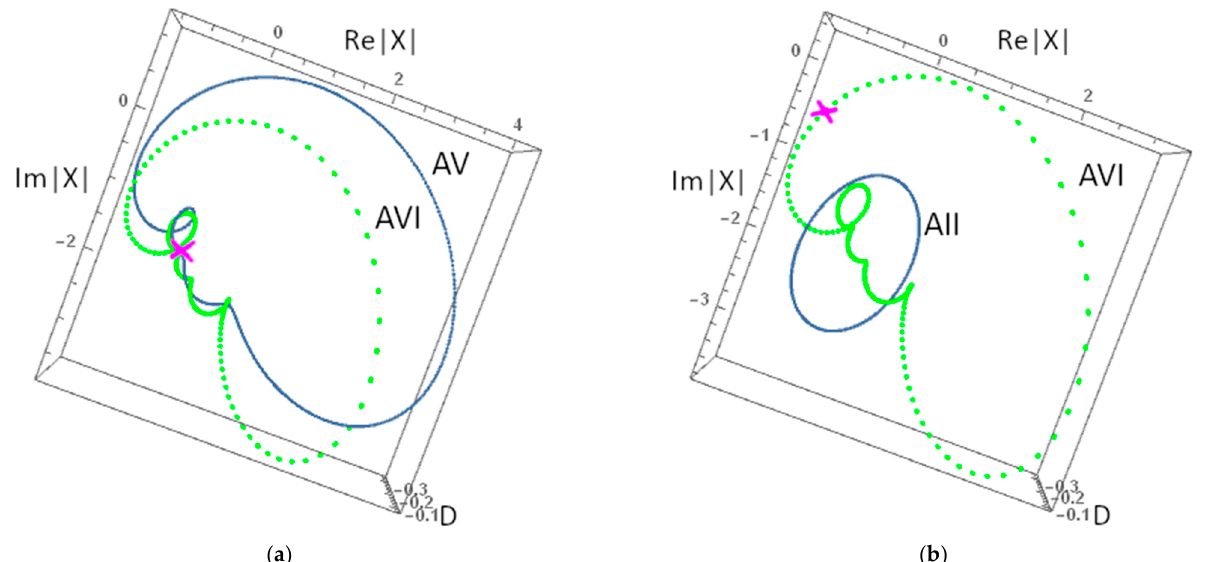
Figure 4. The axes are Re|X|, Im|X|, and D. The magenta x marks the power shift location, the base attractor AVI. ( a ) Down shift from AVI (in green) at Y 0 = 1.96 to AV (in blue) at Y PS = 1.84 . ( b ) Down shift from AVI (in green) at Y 0 = 1.96 to AII (in blue) at Y PS = 1.84 .